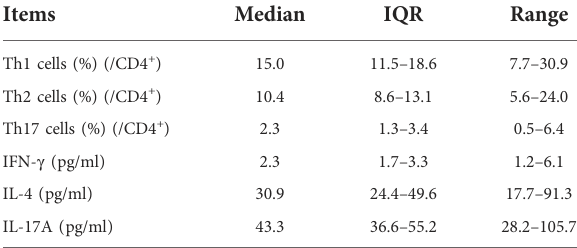
TABLE 3 Information of Th cells and